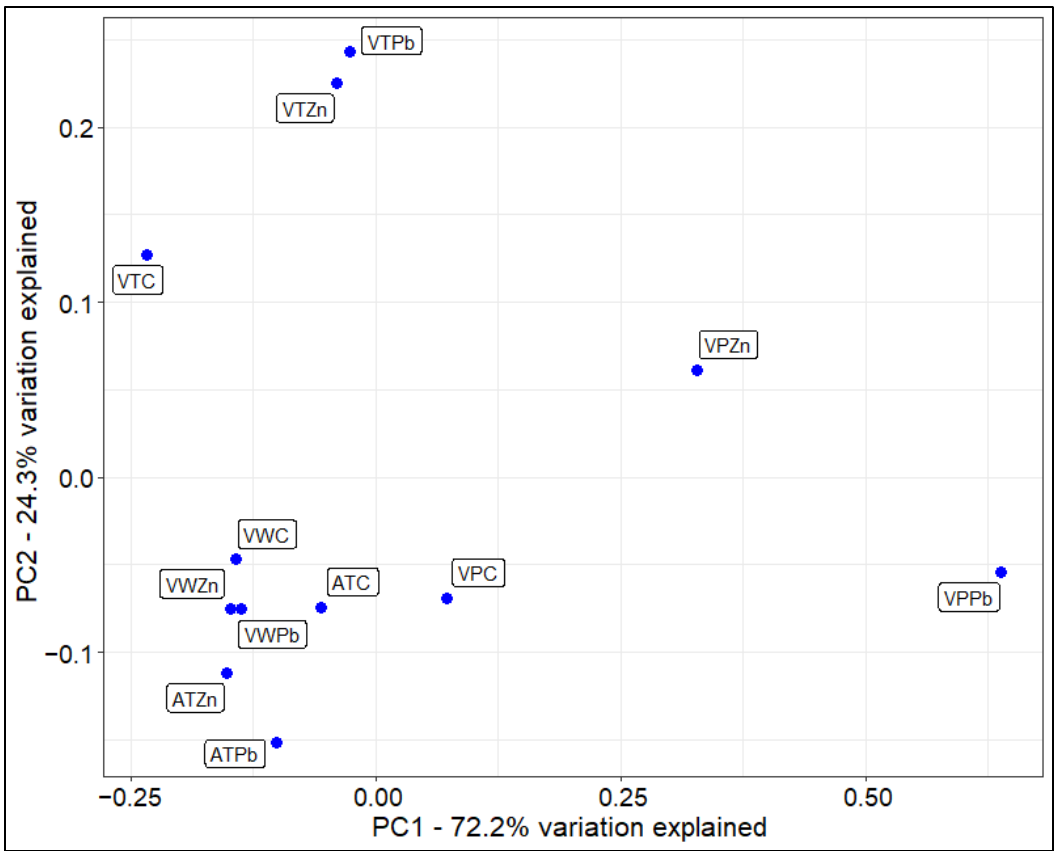
Figure 3. Principal coordinates analysis (PCoA) of Gower’s distances showing differences in average contents of non-enzymatic antioxidants of analyzed species after Zn or Pb treatments. AT— Arabidopsis thaliana ; VW— Viola x wittrockiana ; VT— V. tricolor ; VP— V. philippica ; C, Pb, Zn—control, lead, and zinc treatment,